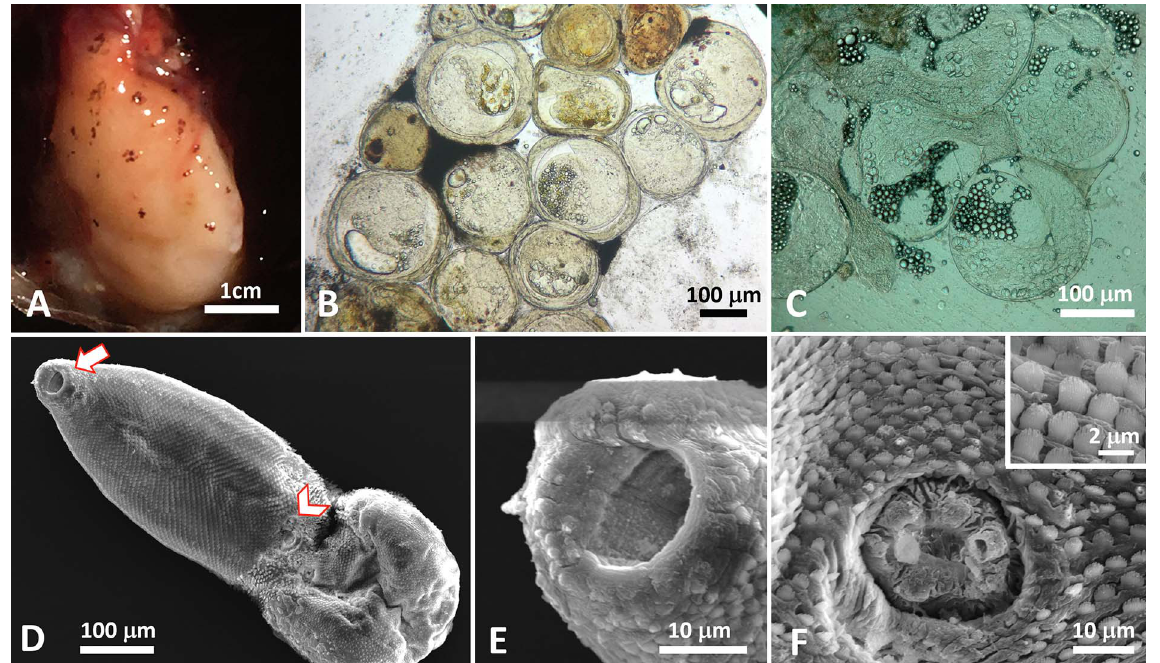
Figure 4. Metacercariae of heterophyid Pygidiopsis genata from Coptodon guineensis at Sebkha Imlili. A. Numerous metacercariae encysted on the outer wall of stomach. B & C. Fresh squashes of infected tissues with clusters of live metacercariae. D. SEM of excysted metacercariae showing a pyriform scaled body with terminal oral sucker (arrow) and subequatorial acetabulum (arrowhead). E. Oral sucker unarmed. F. small ventral sucker. Insert: pectinate body scales.